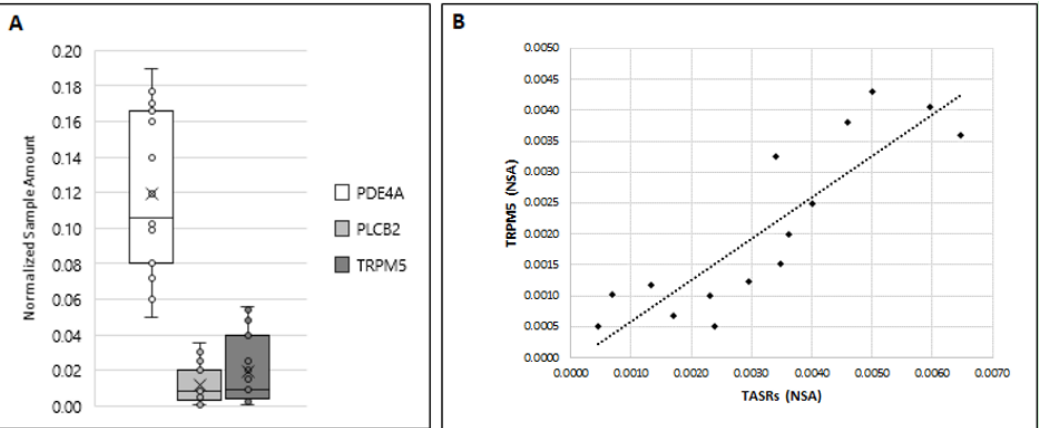
Figure 7. ( A ) Expression of PDE4A , PLCB2 , and TRPM5 in human ejaculated sperm. Graphical diagram is plotted as box–whisker plots, where boxes show the interquartile range with median and mean values, and whiskers represent min and max confidence intervals. ( B ) Correlation between TASRs and TRPM5 ( r = 0.87; p < 0.001) was determined by using Spearman’s correlation analysis.